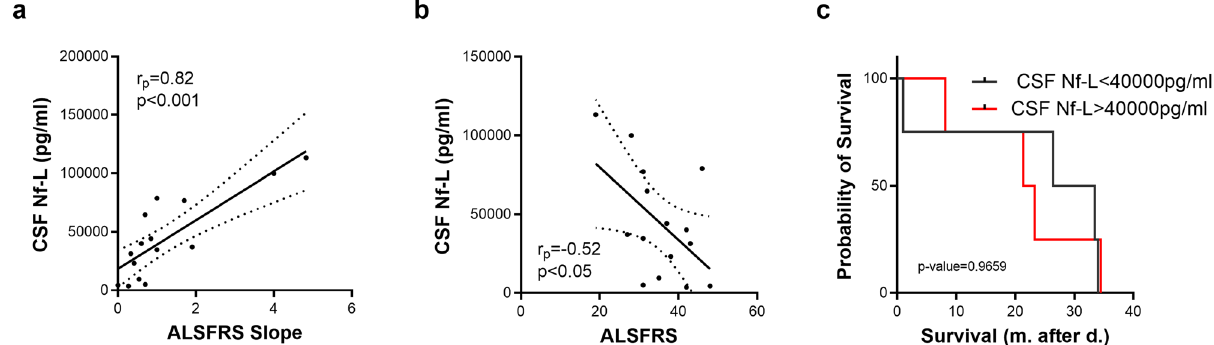
Figure 4. CSF Nf-L association with clinical parameters. Association between Nf-L concentration in CSF and clinical parameters. Kaplan–Meier survival curves of ALS patients according to CSF ( c ) Nf-L levels. Diagnosis Predictors